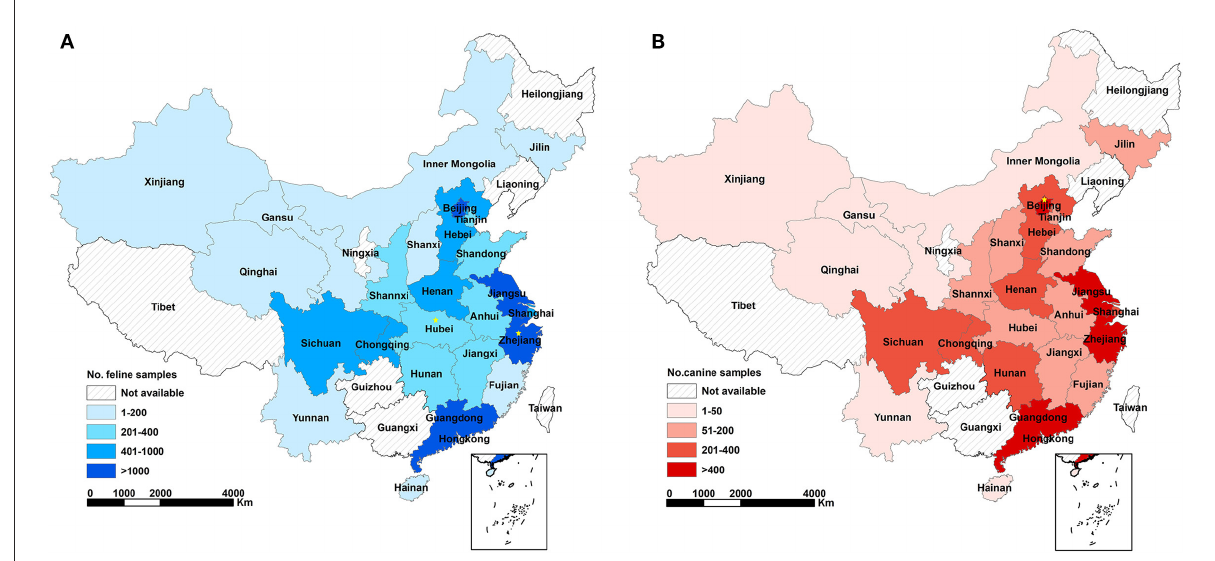
FIGURE1 Geographical coverage of serological survey against SARS-CoV-2 infections in cats (A) and dogs (B) and the amount of analyzed samples in China. Different colors represent corresponding range of sampling numbers in each province. Yellow star represents seropositive case ( n = 1) determined by ELISA and colloidal gold testing